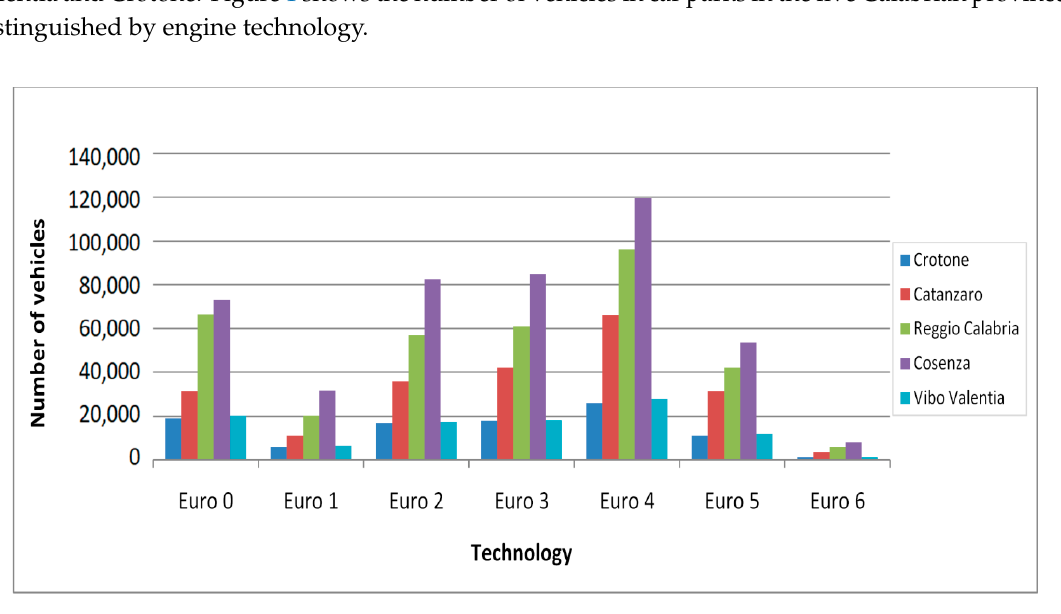
Table 1. Characteristics of the five Calabrian provinces referring to the year 2015.